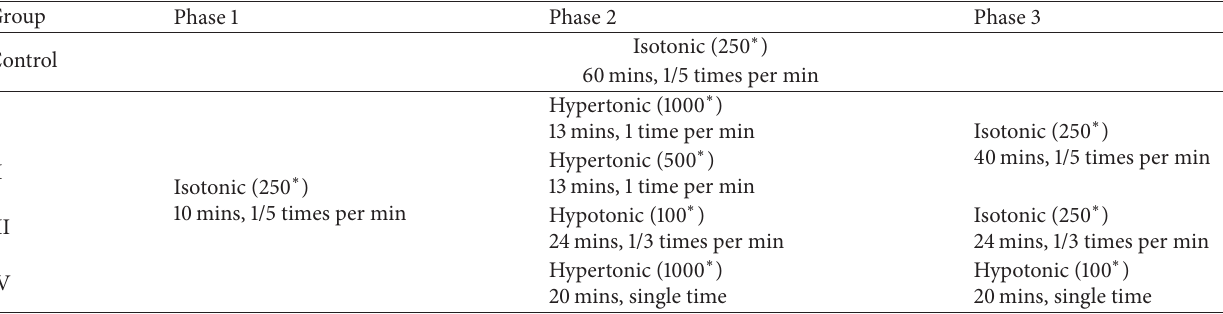
Table 1: Study procedures of Groups